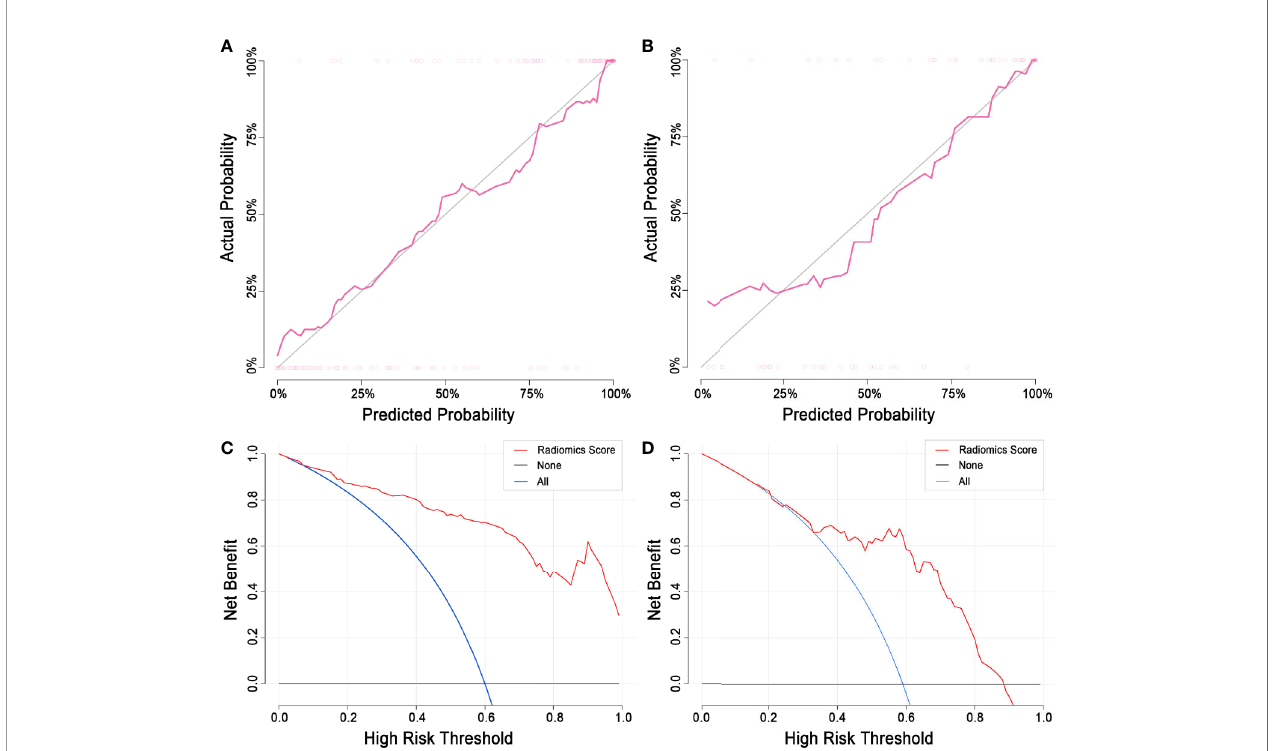
FIGURE 7 | Calibration curve and decision curve analysis of the radiomics model. (A) The calibration curve of the training set. (B) The calibration curve of the test set. The diagonal line represents a perfect classi fi cation. (C) DCA of the training set. (D) The DCA of the test set. The y-axis indicates the net bene fi t. The net bene fi t is determined by calculating the difference between the expected bene fi t and the expected harm associated with each proposed model [net bene fi t = true positive rate – (false positive rate × weighting factor); weighting factor = threshold probability/(1-threshold probability)]. The blue line represents the assumption that all LNs are malignant. The black line represents the assumption that all LNs are benign. DCA, decision curve analysis; LN, lymph